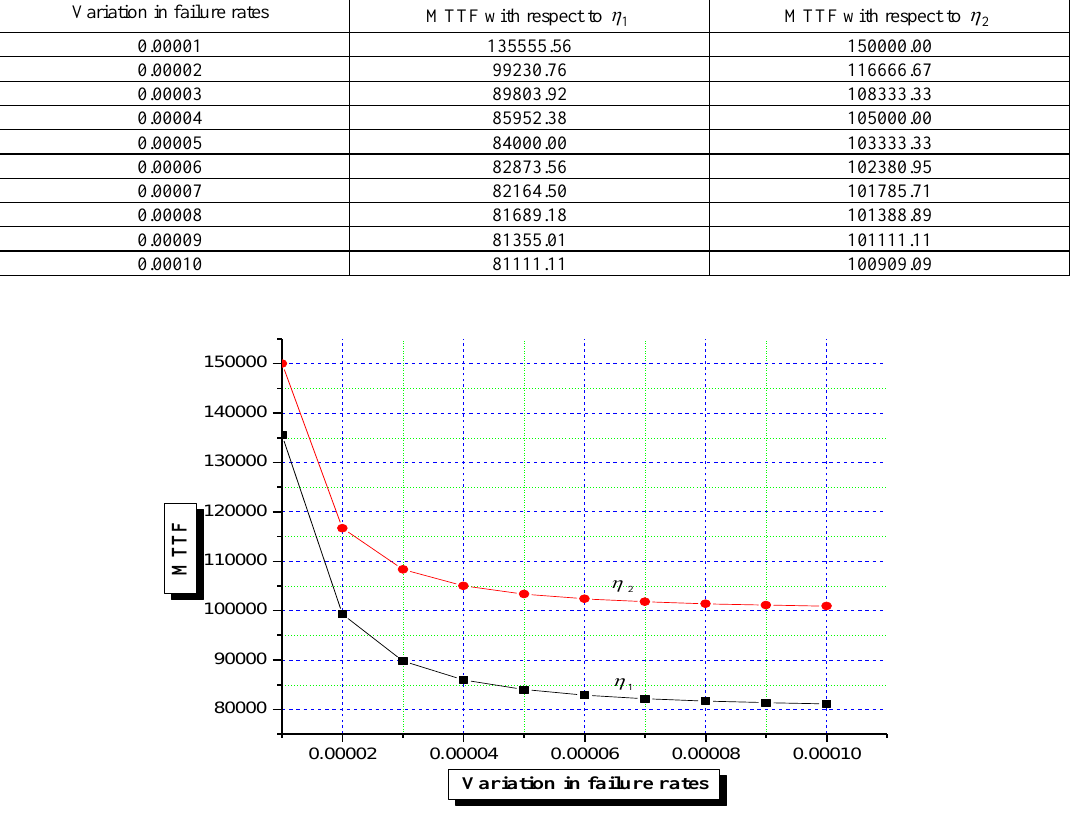
Figure 5. MTTF W.r.t. variation in failure